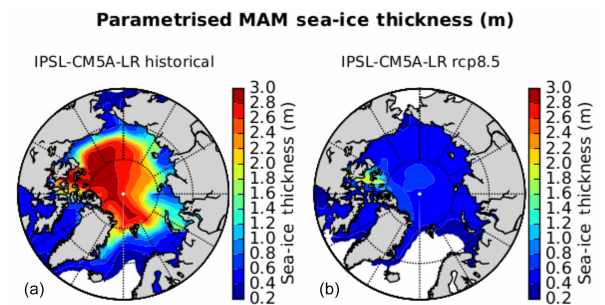
Figure 3. Spring (MAM) estimated mean SIT (m) using parame- terisation from Krinner et al. (1997) and IPSL-CM5A-LR SIC data from the historical run (1971–2000, a ) and the RCP8.5 scenario (2071–2100, b